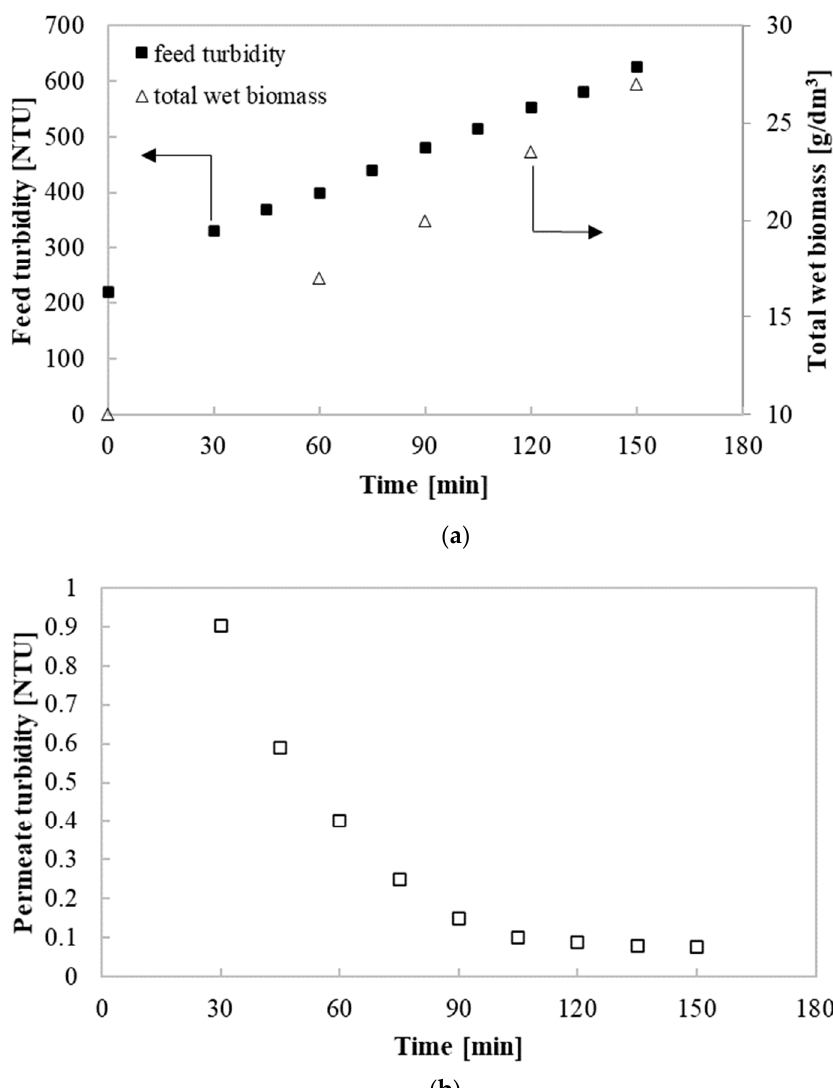
Figure 2. Changes of ( a ) feed turbidity and total wet biomass and ( b ) permeate turbidity during UF process.